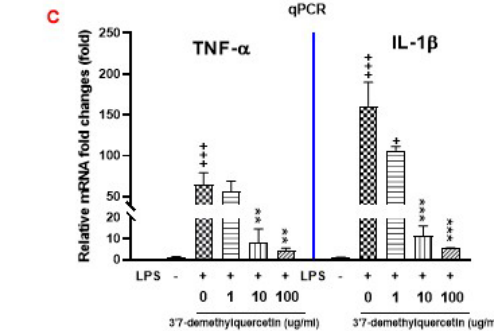
Figure 3. Effects of isolated compounds from hexane extract in lipopolysaccharide (LPS) stimulated RAW 264.7 cells. Data represent means ± SEM. + p < 0.05, +++ p < 0.001 compared to control, ** p < 0.01, *** p < 0.001 compared to LPS. Treatment of RAW 264.7 cells with LPS alone resulted in significant increases in pro-inflammatory cytokines (TNF- α and IL - 1β) and mRNA levels as compared to the control group. However, the expression of TNF- α and IL - 1β mRNA levels in EA325H ( A ) and 3′ ,7-dimethylquercetin ( B ) treated group showed a dose-dependent decrease as compared to the LPS group. ( C ) mRNA expression was determined with